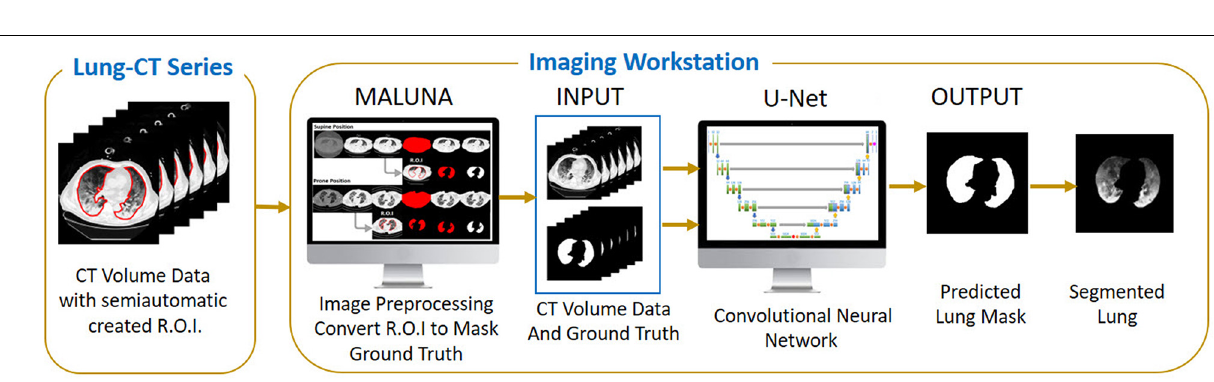
FIGURE 6 | The complete training workflow.